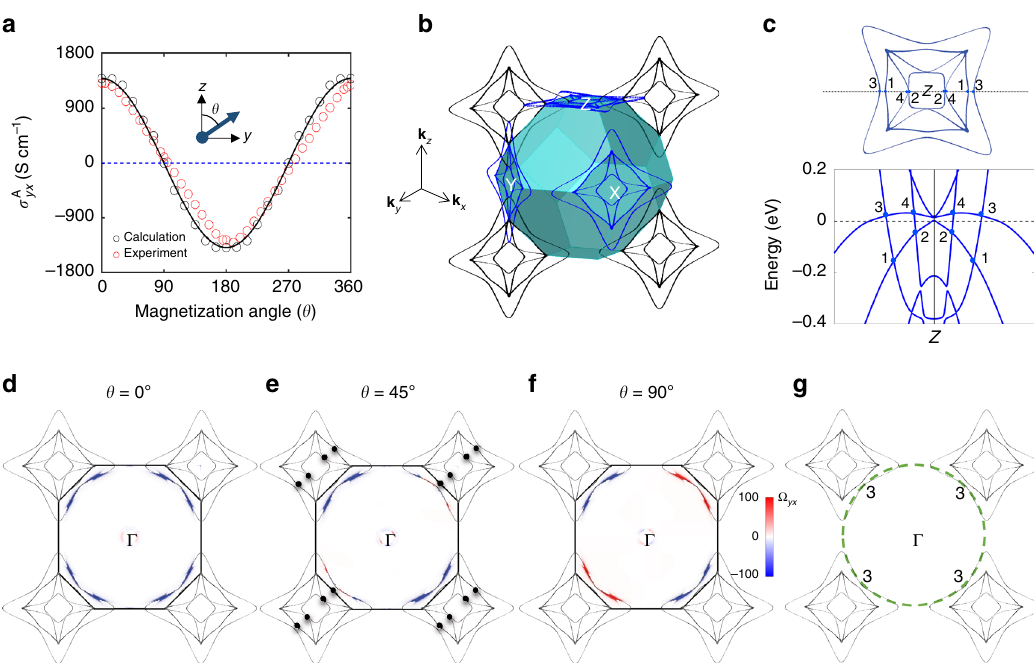
Fig. 3 The anomalous Hall effect and topological band structure. a The anomalous Hall conductivity σ A yx as rotating the magnetization from the z -axis to y - axis. The experimental and theoretical results are represented by red and black circles, respectively. The solid curve is a cosine pro fi le to guide eyes. b Nodal rings and the fi rst Brillouin zone of Co 2 MnAl. Without SOC, there are nodal rings in these mirror planes, k x , y , z = 0 or π . For example, there are four nodal rings that are labeled as #1 – 4 in c , centered at the Z point of the FCC Brillouin zone. When magnetization align along the [001] direction by SOC, all nodal rings are gapped out because of the mirror symmetry breaking, except those in the k z = 0 or π plane. The preserved nodal rings and related band structure are shown in c . The band dispersion, in which the nodal ring crossing points are indicated by blue dots, is along the black dotted line in the upper panel. d – f The Berry-curvature ( Ω yx ) distribution in the k x = 0 plane centered at Γ for different magnetization angle ( θ ). Nodal rings (black) are gapped out in this plane. Near the charge neutral point, the Berry curvature is mainly contributed by the gapped nodal ring #3. When θ = 45°, nodal rings #1 and #4 evolve into Weyl points ( fi lled black circles in e ), while nodal rings #2 and #3 are fully gapped. g The nodal ring #3 at four corners can be treated as the reconstruction of a large ring, which is illustrated by a green dashed circle, centered at Γ